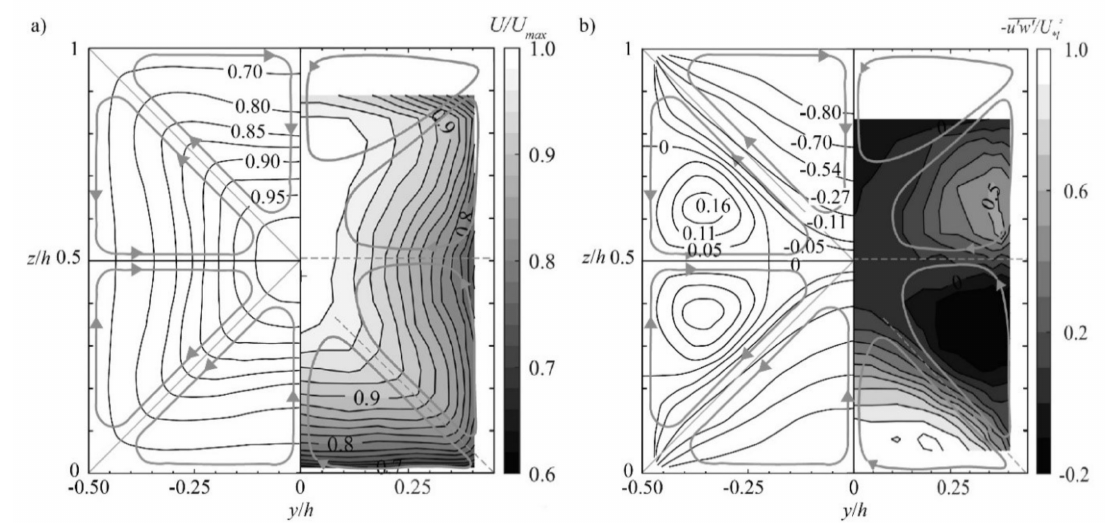
Figure 14. Comparison of duct (left halves) and open channel flows (right halves): Contour plots of normalized ( a ) streamwise flow velocities, and ( b ) Reynolds shear